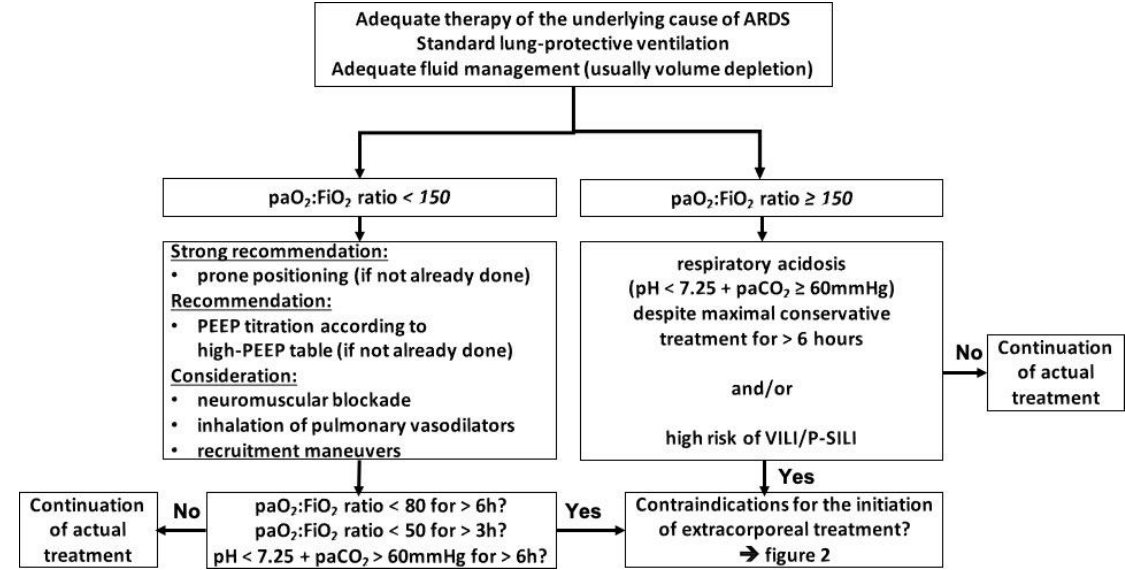
Figure 1. Algorithm to indicate ECMO initiation; adapted from [19] , modified from [1,5,20] . Abbreviations: ARDS = acute respiratory distress syndrome, paO 2 = partial arterial pressure of oxygen, FiO 2 = inspiratory oxygen fraction, paCO 2 = partial arterial pressure of carbon dioxide, PEEP = positive end-expiratory pressure, VILI = ventilator-induced lung injury, P-SILI = patient self-inflicted lung injury.